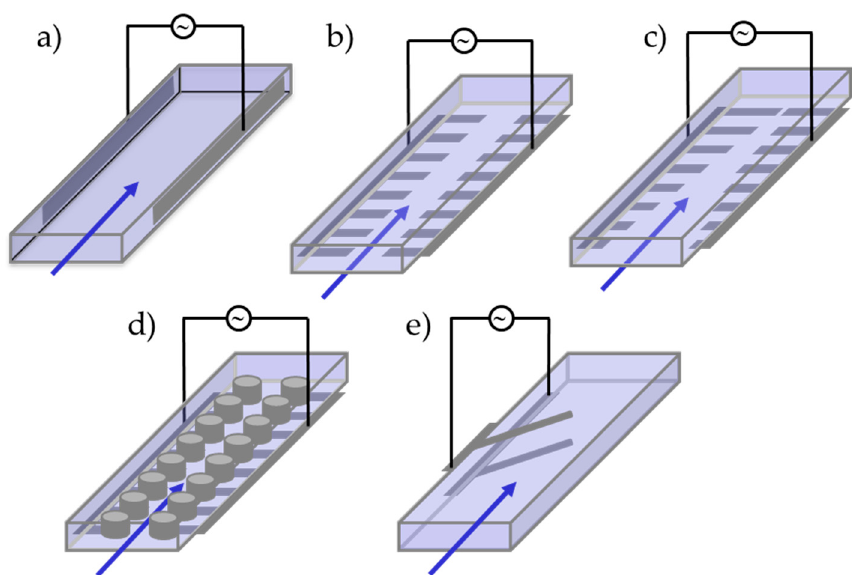
Figure 5. Schematics of channel-electrode configurations used in DEP studies on microalgae. Electrode configurations are ( a ) planar parallel, ( b ) planar interdigitated, ( c ) modified planar interdigitated, ( d ) micro-post and ( e ) angled